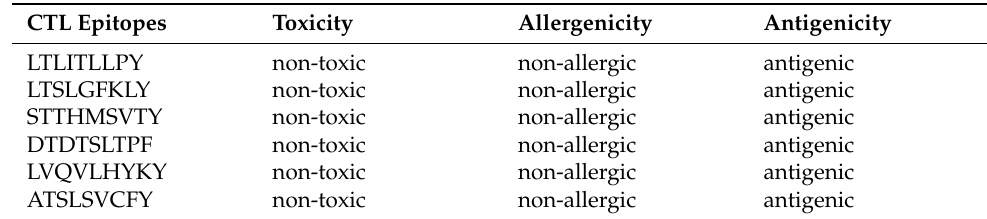
Table 2. The CTL epitopes selected after screening through toxicity, allergenicity, and antigenicity predictions.